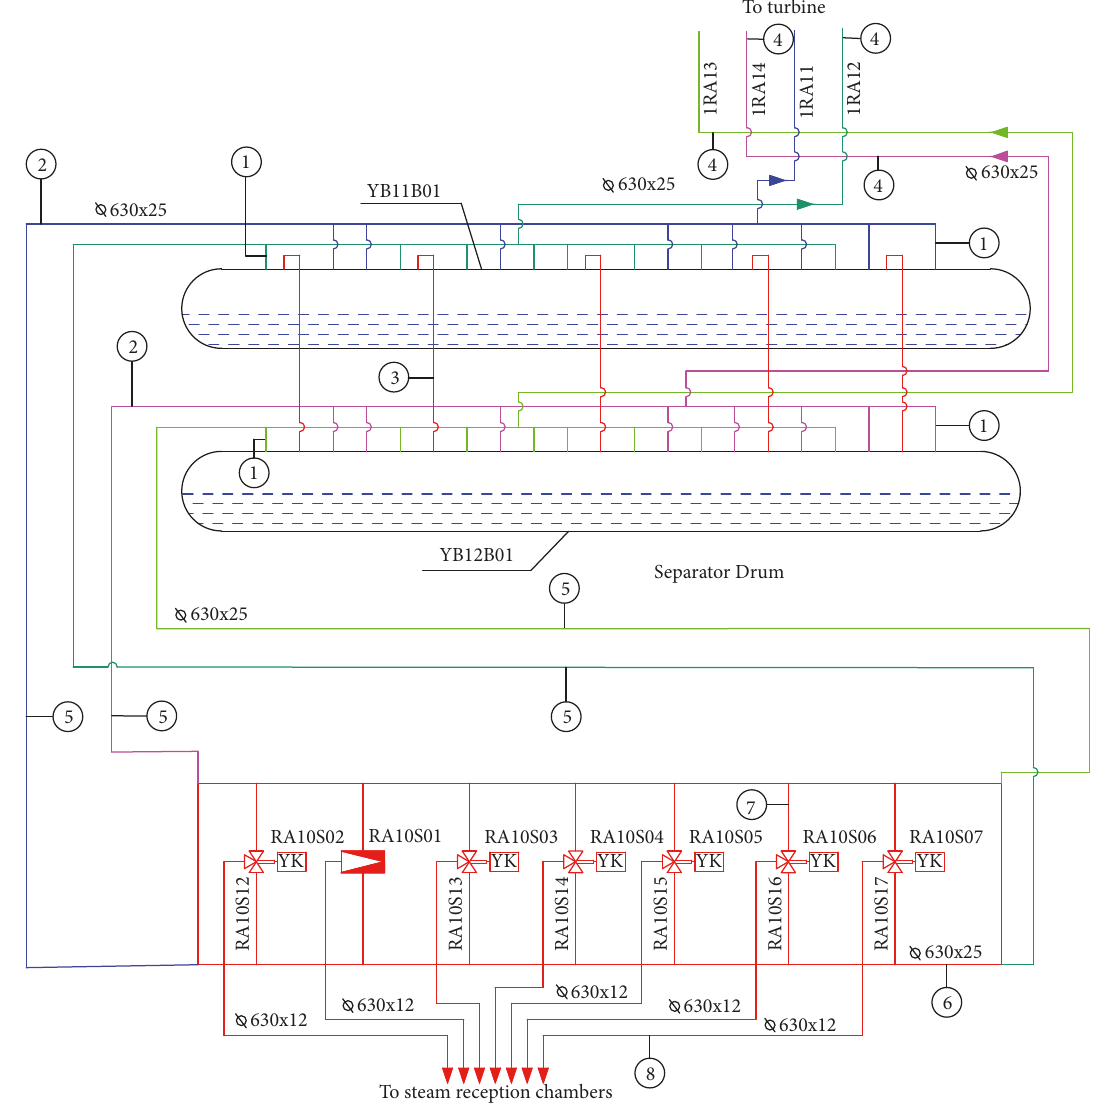
Figure 1: Simplified SP-HPR